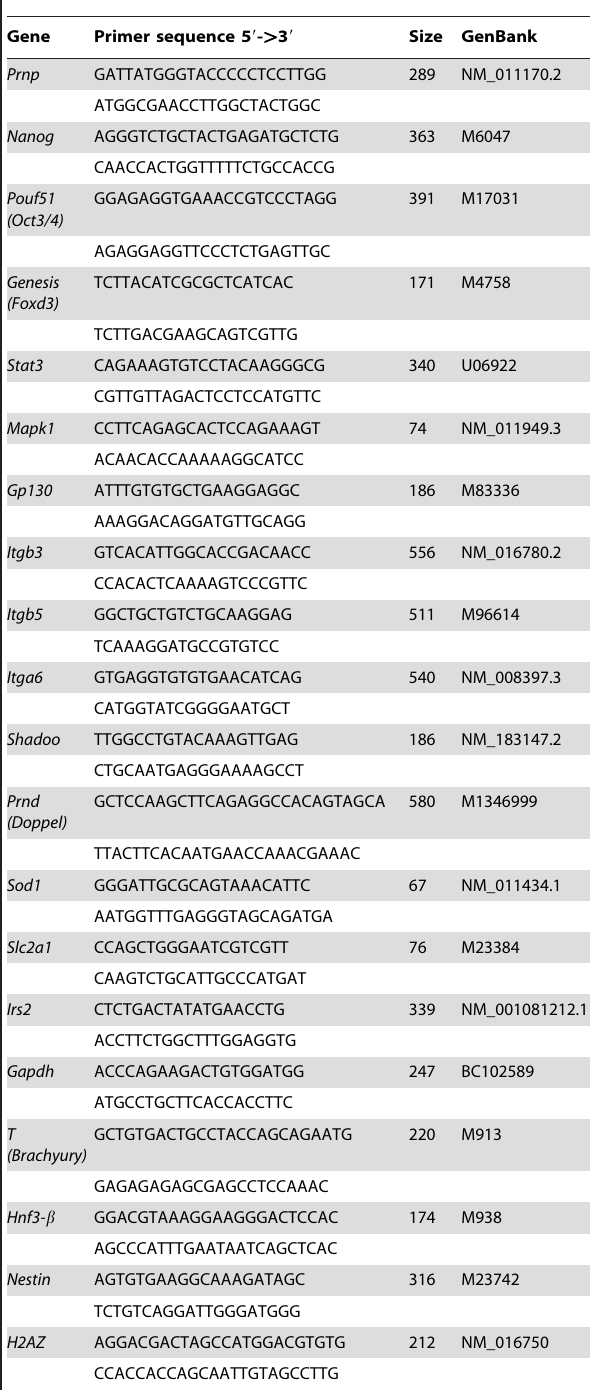
Table 1. Primers used for